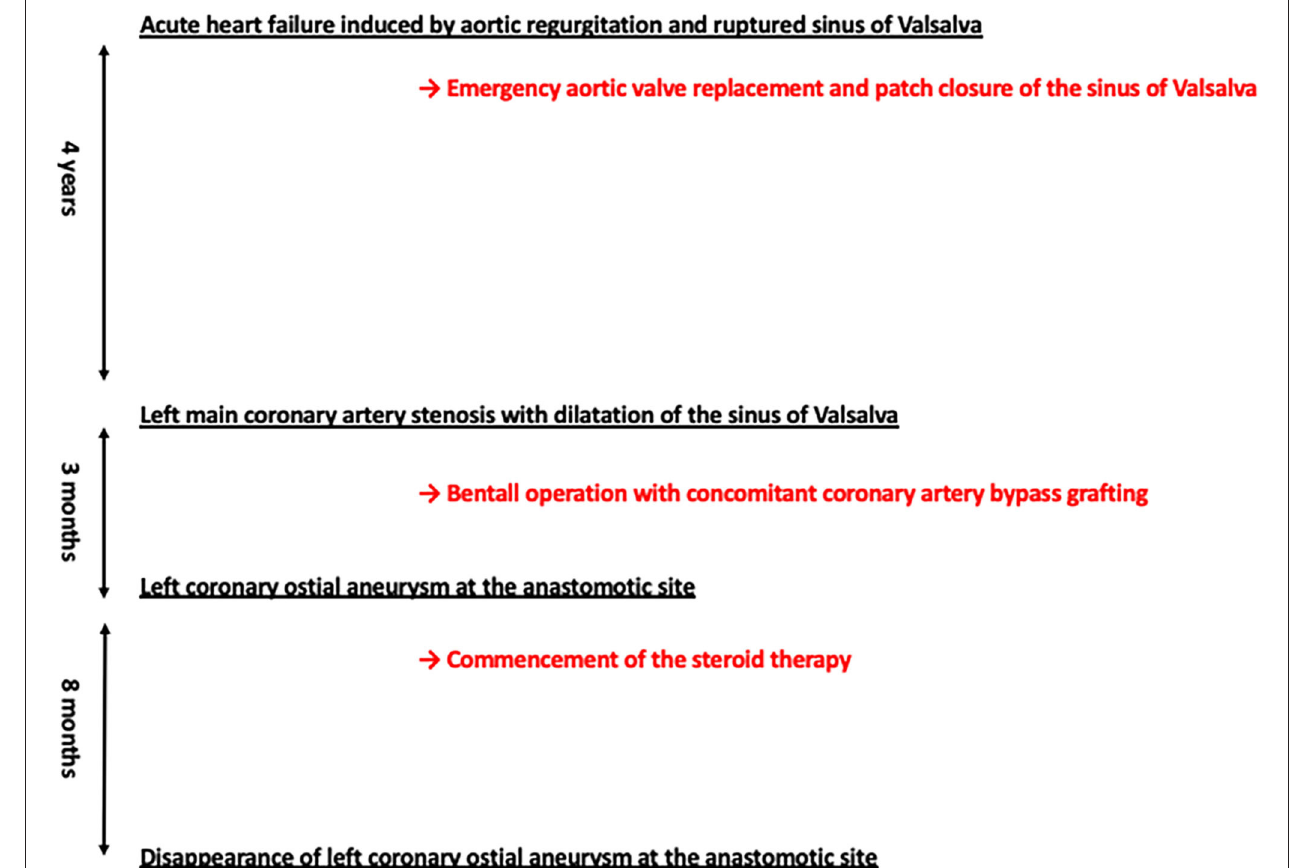
FIGURE 3 | Clinical courses of this